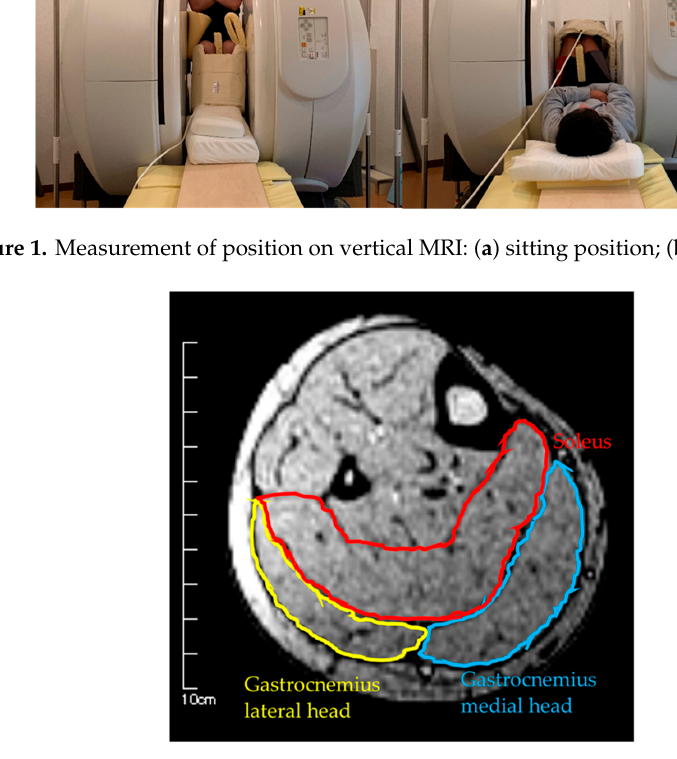
Figure 3. Measurement of muscle thickness by ultrasonography: ( a ) soleus; ( b ) gastrocnemius lateral head; ( c ) gastrocnemius medial head. Arrows indicate muscle thickness. 2.3. Statistical Analysis Statistical analyses were performed using SPSS Ver. 24 (IBM SPSS Statistics, Japan IBM, Tokyo, Japan). For statistical analysis, three portions were selected: 25%, 50%, and 75% (0% is fibular head and 100% is lateral malleolus) of the muscle (Figure 4). The lower leg length of the participant with the longest lower leg length was 35.0 cm; therefore, all participants were able to obtain 75% portion image by MRI. p values < 0.05 were considered significant. After confirming the normality of the data with the Shapiro–Wilk test, paired t-test was used for the comparison of the MCSA in the lying and sitting positions and muscle volume on the MRI. Pearson’s correlation coefficients were used to determine the relationship between MCSA and MT. One-way analysis of variance and the Bonferroni test were used to compare the MCSA in the same region, the volume of each muscle, and the MCSA in each region in the same muscle in the lying position. All measurements are presented as the mean ± standard deviation.